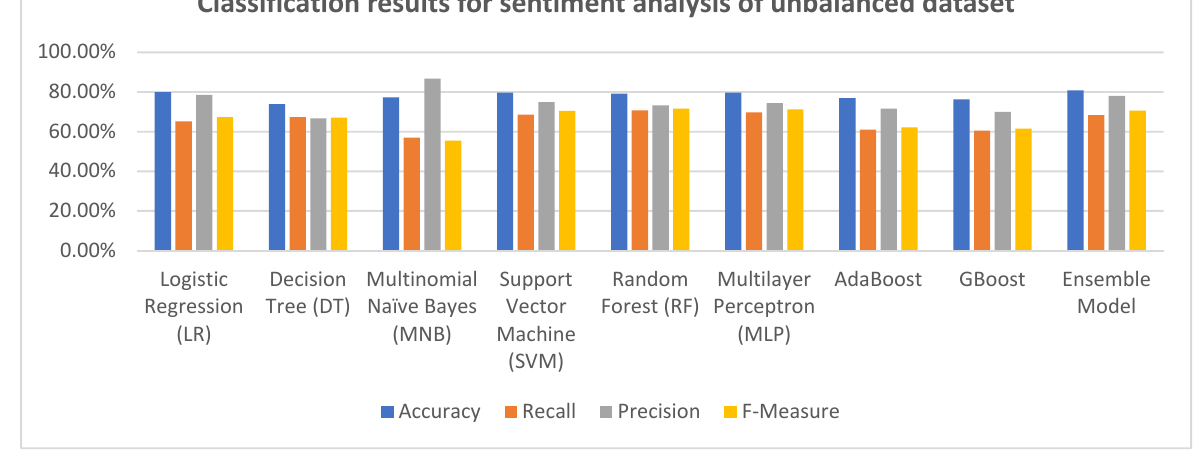
Figure 4. Classification results for sentiment analysis of unbalanced dataset.